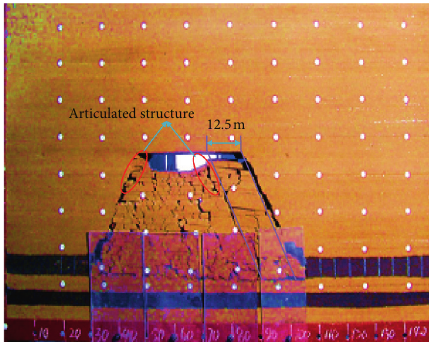
Figure 9: 37.5m advancement.